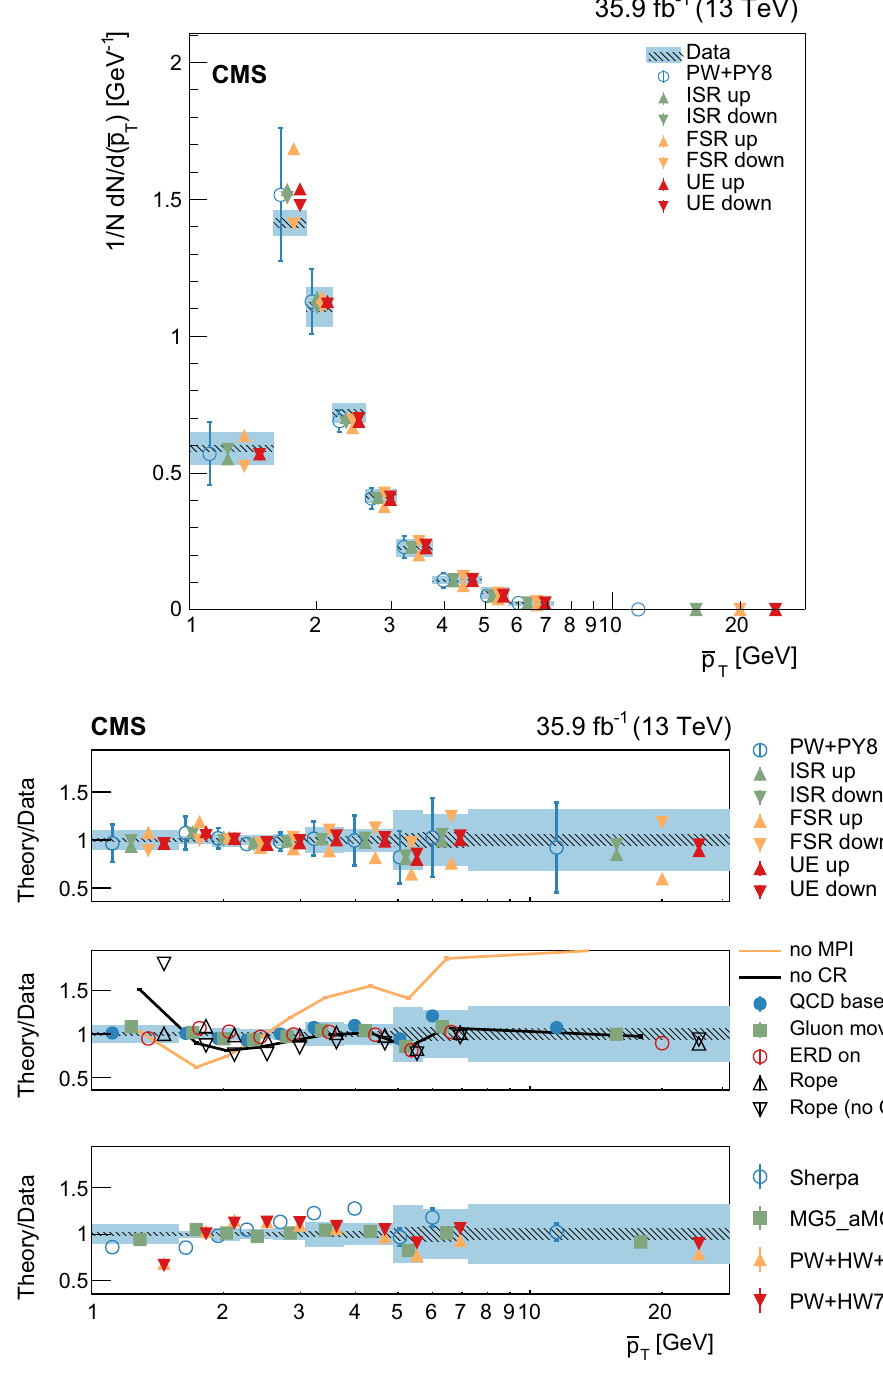
Fig. 6 Normalized differential cross section as function of p T , compared to the predictions of different models. The conventions of Fig. 4 are